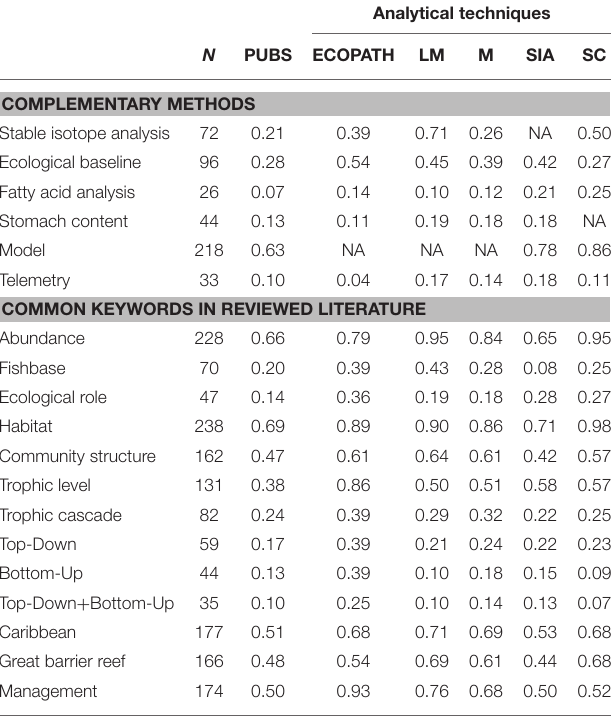
TABLE 2 | Proportion of reviewed publications that use additional methods for trophodynamic study or mention common keywords in related literature ( N = 398). EndNote® (Thompson Reuters) was used to annotate documents for